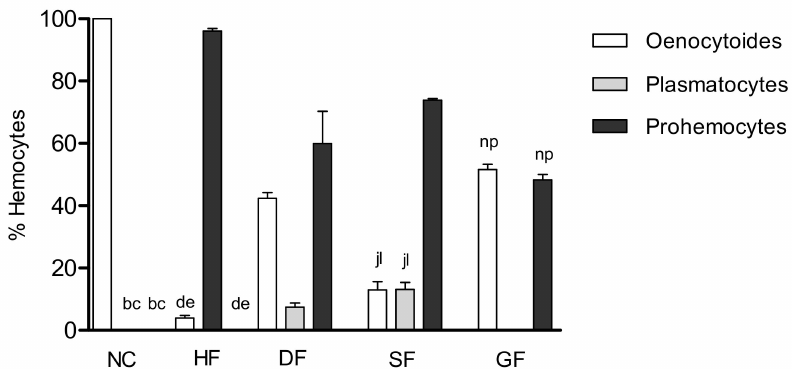
Figure 5. Hemocytes present in larvae exposed to substances. HF: Hexane Fraction; DF: Dichloromethane fraction; SF: Sulphated Flavonoid, GF: Glucoside Flavonoid and NC: Negative Control. Bars with the same letter are not significantly di ff erent by Tukey test,